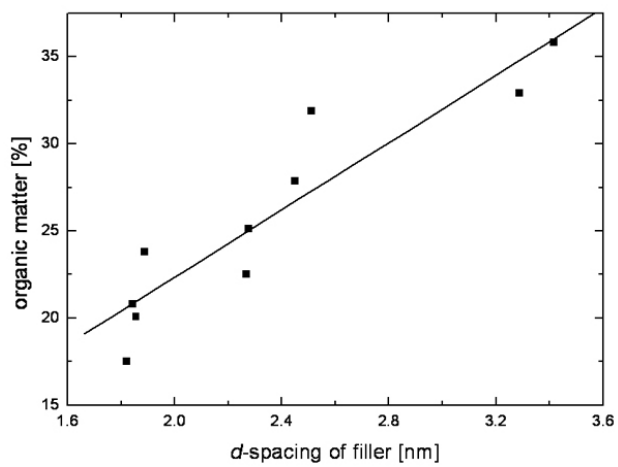
Figure 6. Correlation between the organic matter ionically bound to the layered silicate surface and the resulting basal plane spacing of the modified filler. Reproduced from reference [43].